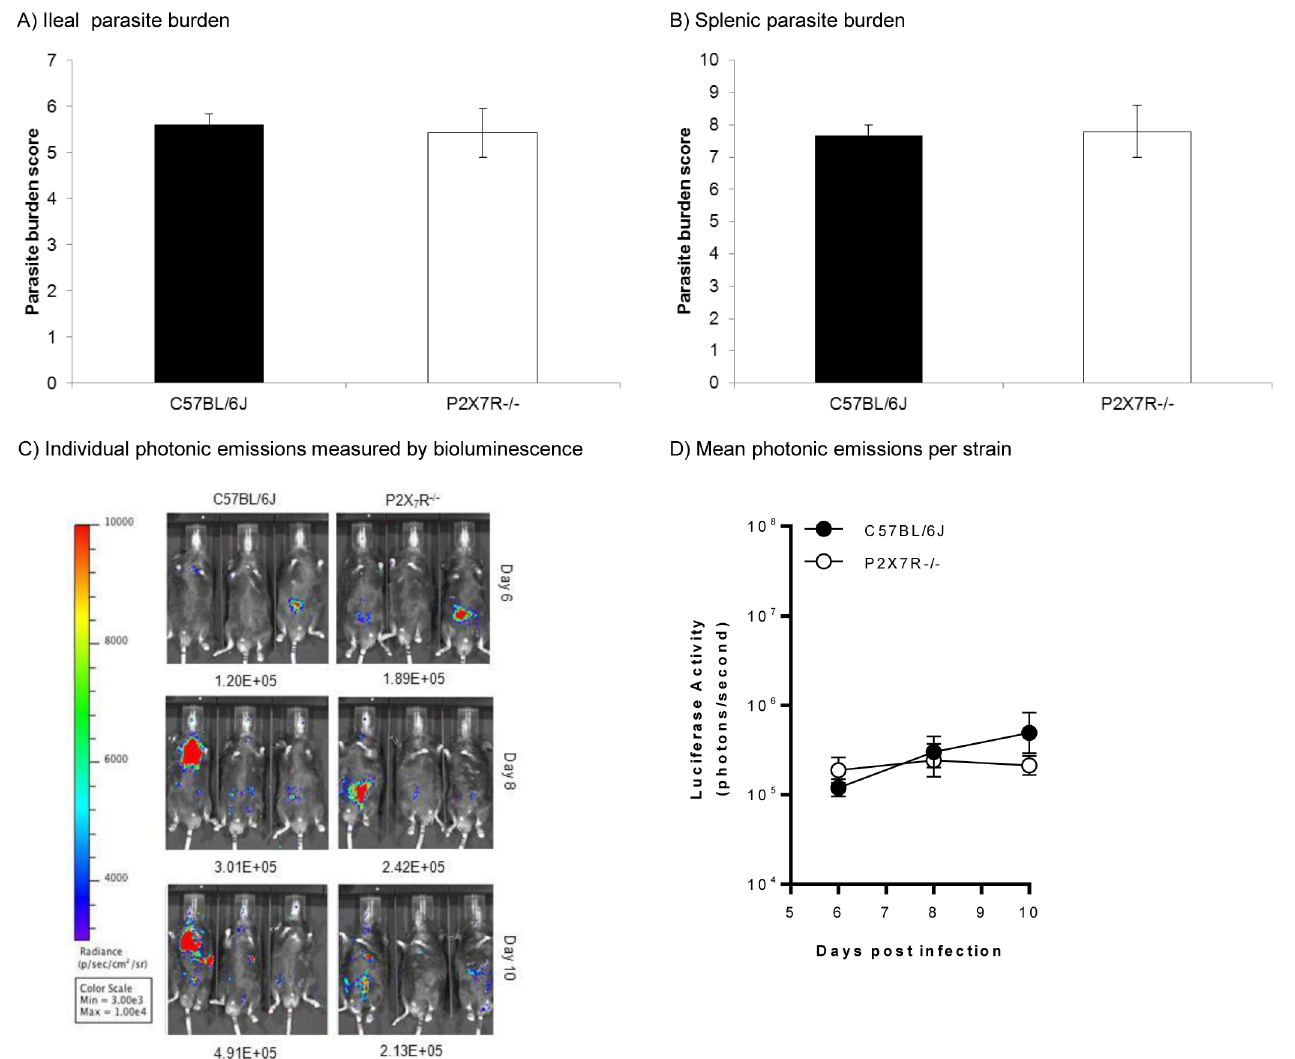
Fig 2. Control of Toxoplasma gondii is not altered in P2X7R -/- mice compared with wild type. Male mice (6 – 8 weeks old) were infected orally with 10 T . gondii ME49 cysts and euthanased 8 days post-infection. Parasite burden in (A) intestines and (B) spleens of C57BL/6J and P2X7R -/- mice was determined by a microtitre limiting dilution assay as detailed in the Materials and Methods. Results are presented as the mean ± SEM (n = 8) for both strains of mice from one of three experiments that generated similar data. Parasite burden measurements from infected P2X7R -/- mice were not significantly different from infected C57BL/6J mice (one-way ANOVA). Identical results were obtained using the classical plaque-forming assay [61] so these are not shown here. (C, D) In a separate series of experiments, three male and three female mice were infected orally with 5 cysts of luciferase-expressing 76K GFP-Luc T . gondii and parasite burden was quantified on day 6, 8 and 10 p.i. by firefly luciferase activity using an IVIS BLI system from Caliper Life Sciences as described previously [32]; images of three infected male C57BL/6J and three infected male P2X7R -/- mice are shown (C). Parasite burden measurements (D) from infected P2X7R -/- mice (n = 6) were not significantly different from infected C57BL/6J mice (n = 6) on any of day 6, 8 or 10 p.i. (two-way